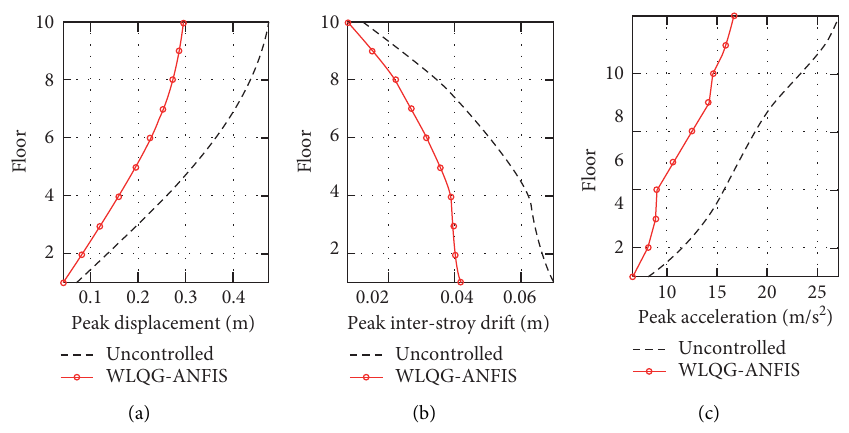
Figure 24: Peak responses due to scaled Kobe